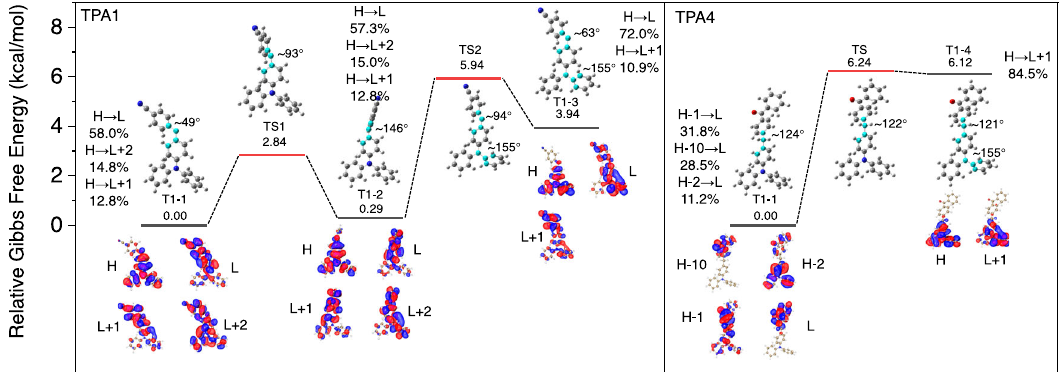
Fig. 6 Theoretical computations on the conformations and molecular orbital transitions for dual phosphorescence. Calculated relative Gibbs free energies and global/local-minima geometries (T1 – 1, T1 – 2, T1 – 3, and T1 – 4) of T 1 state, the related transition states (TS) between these geometries, the optimal geometries with dihedrals of highlighted atoms, and main molecular orbital transition contributions for T 1 emissions (>10%; H HOMO, L